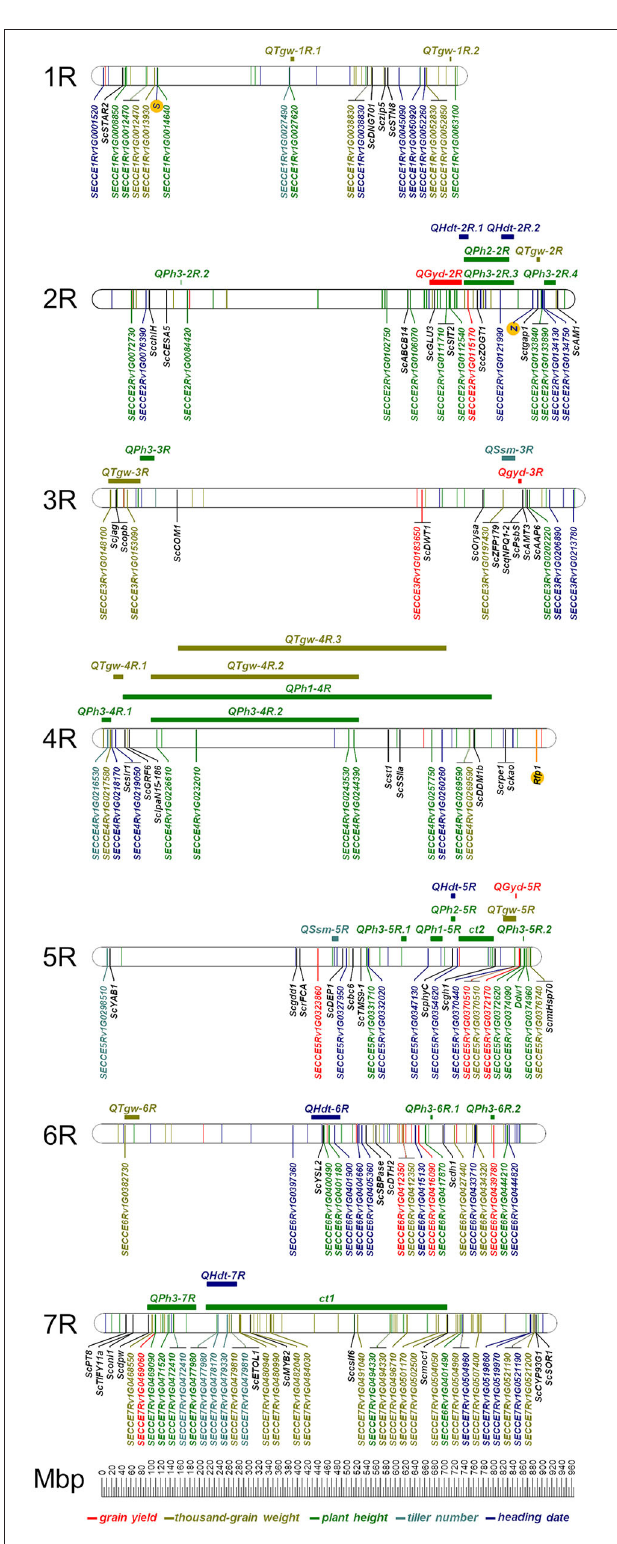
FIGURE 8 | Physical position of cross-validated SNPs in protein coding sequences of the ‘Lo7’ genome assembly detected in the GWAS for grain yield, thousand-grain weight, plant height, tiller number and heading date.